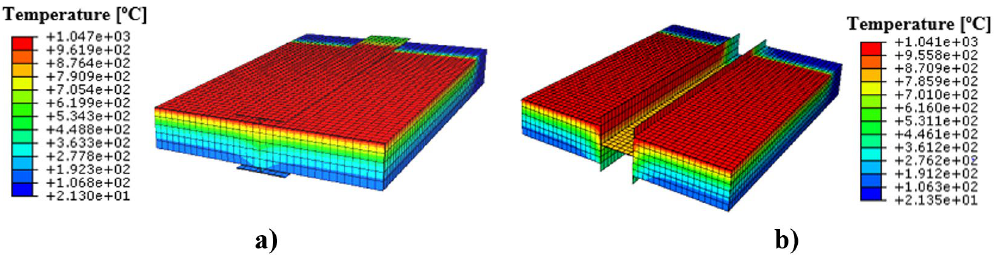
Figure 7. Columns thermal field: (a) H220-ORT-T15; (b) H220-PAR-T15.